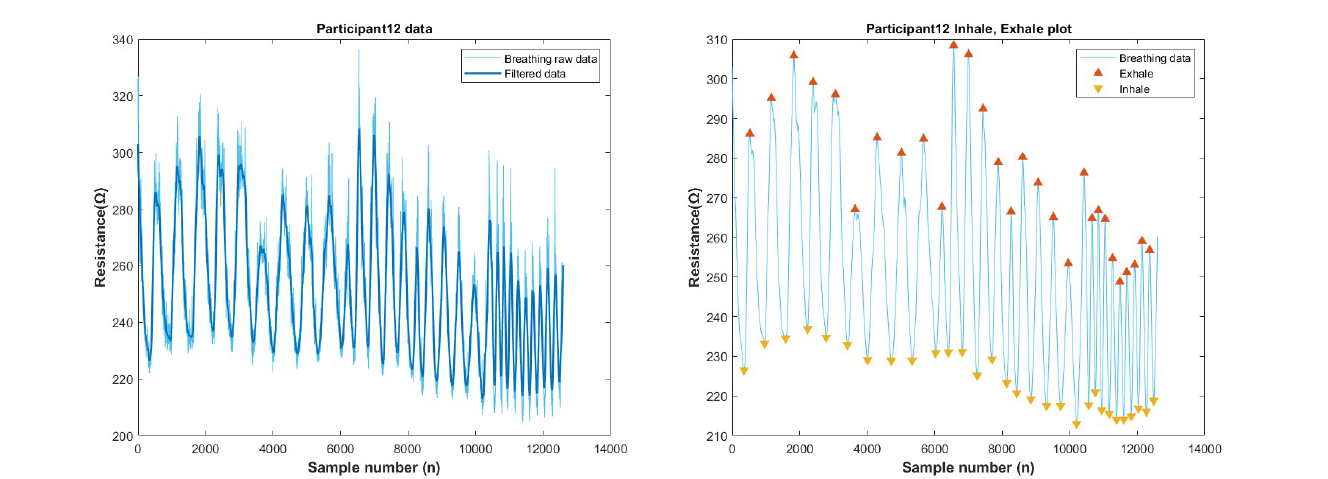
Figure A27. Breathing Test data of Participant number-12.